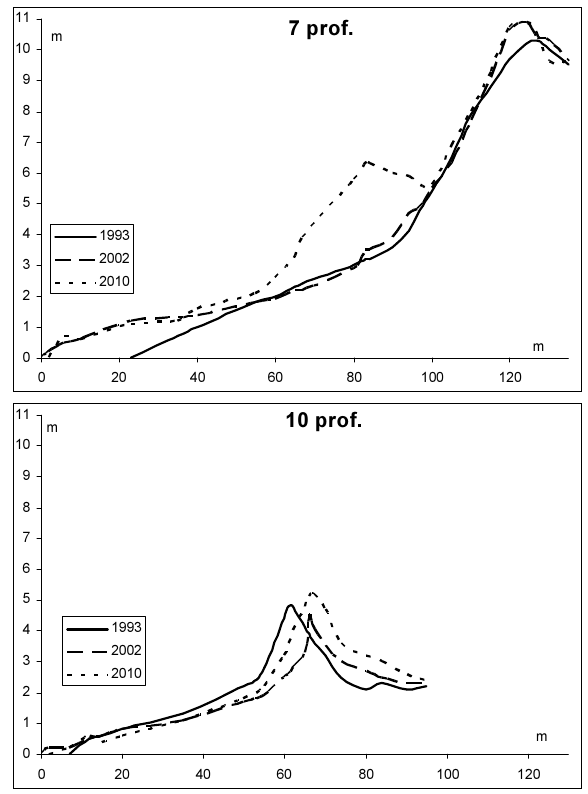
Fig. 6. Coast cross-profile changes to the south from the port jetties. Profile locations are marked in Fig. 1